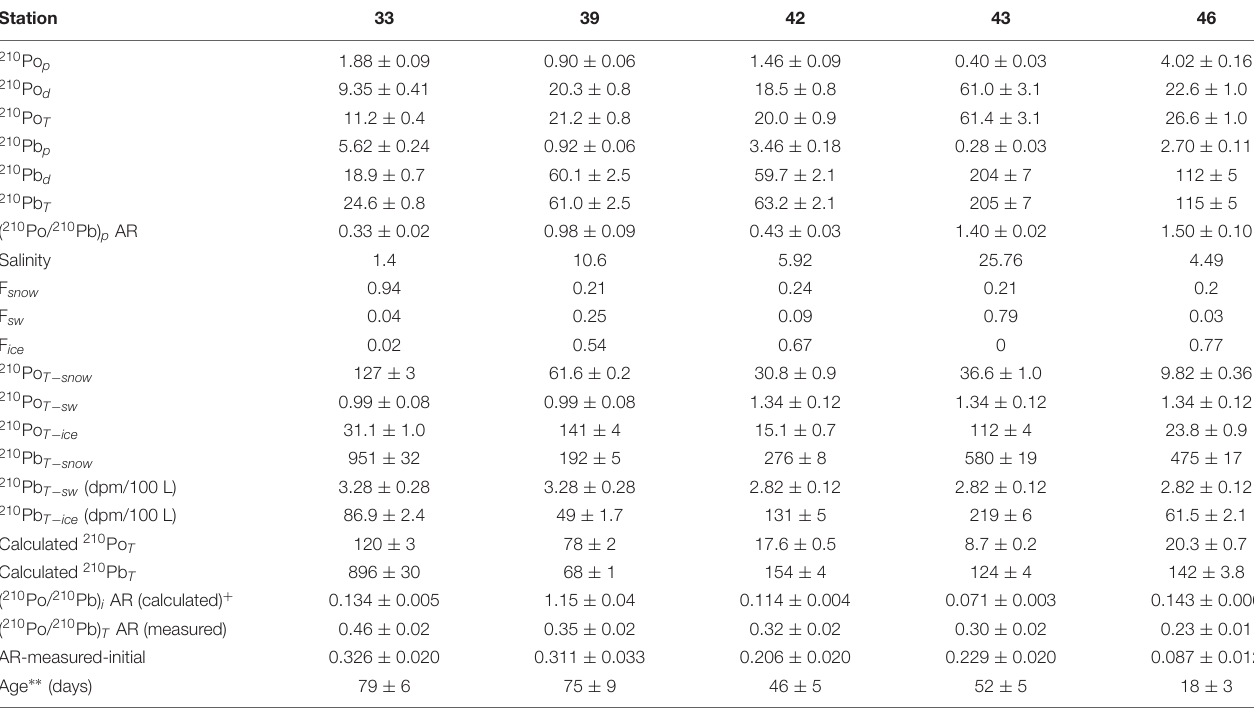
TABLE 5 | *Activities of 210 Po and 210 Pb (dpm/100 L), fractional amounts snow (F snow ), ice (F ice ), and seawater (F sw ), and age** of melt ponds.